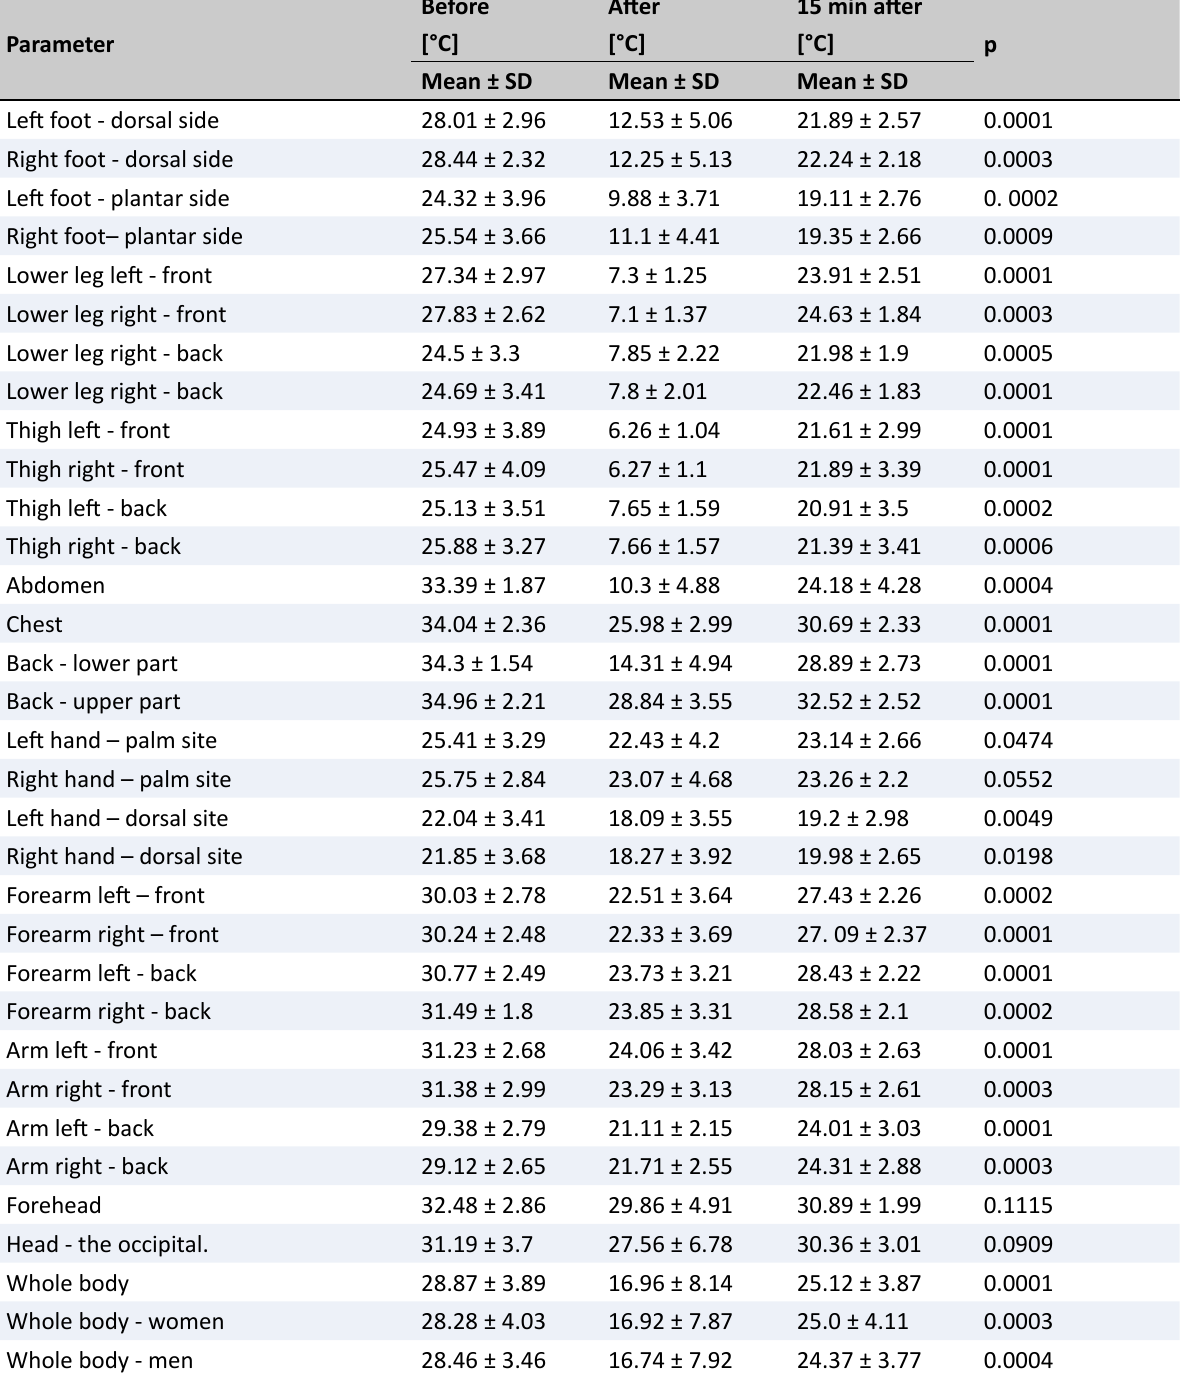
Table 1 . Characteristics of all parameters measured during the